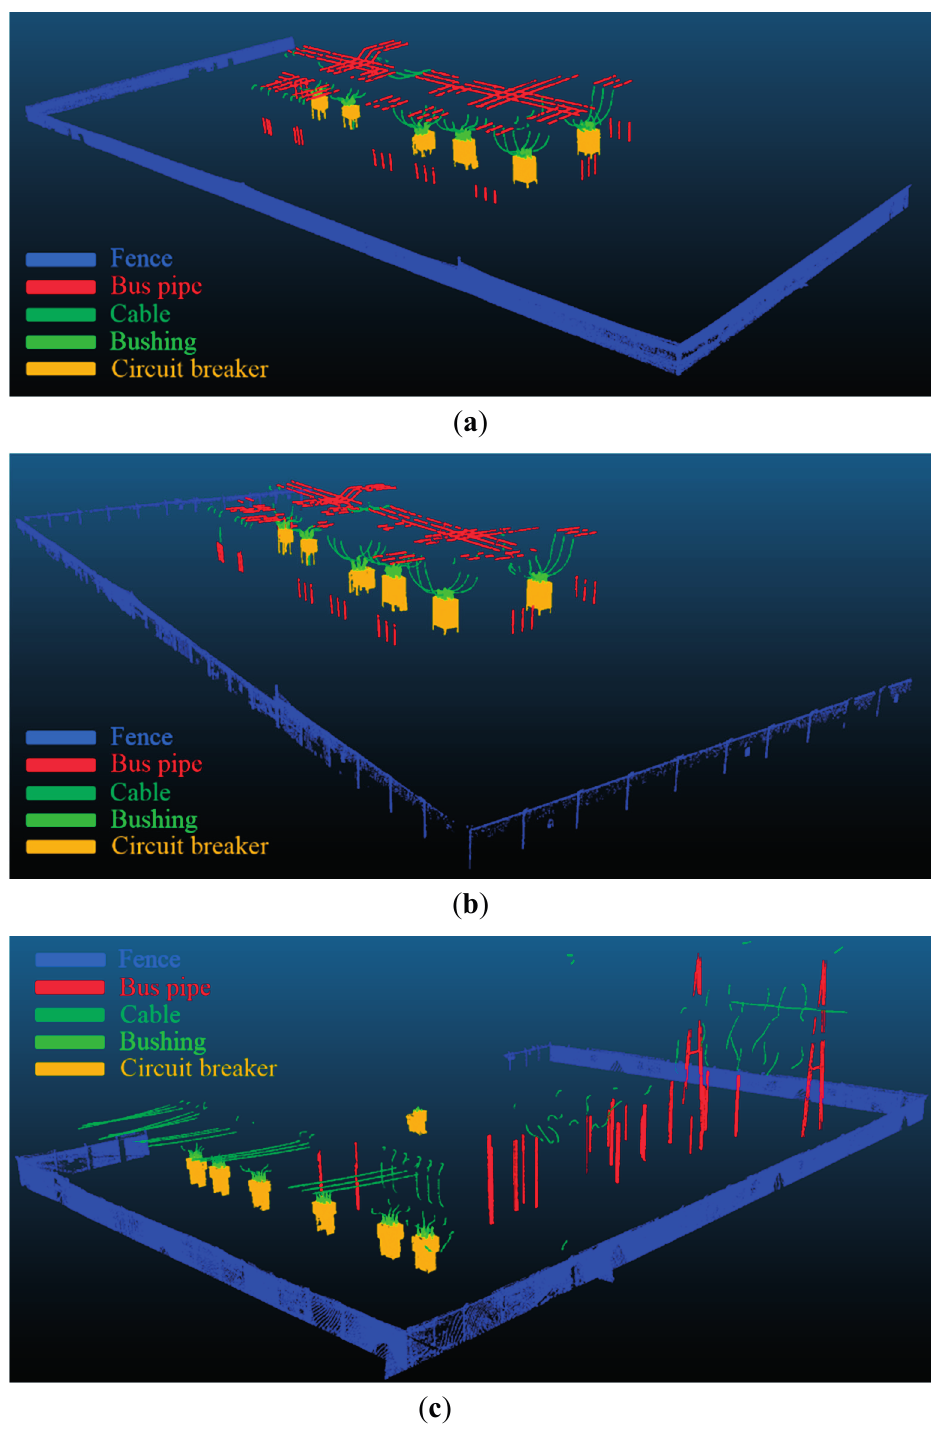
Figure 20. Recognized object types in the first dataset ( a ), second dataset ( b ) and third dataset ( c ). Each color represents a different type of